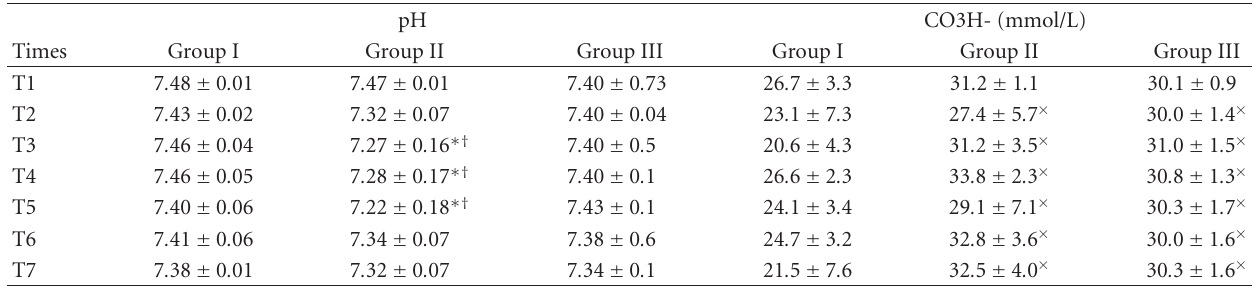
Table 4: Acid-base balance in pigs anesthetized with sevoflurane, fentanyl, and vecuronium and undergoing aortic cross-clamping through laparotomy (Group I) or laparoscopy with (Group II) or without aortic cross-clamping (Group III). pH